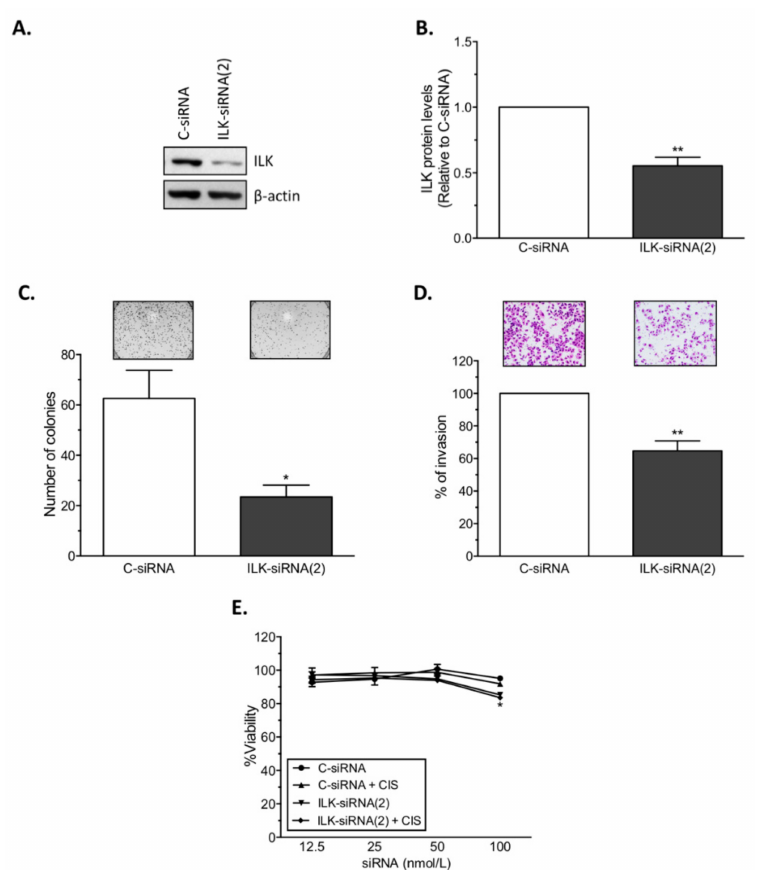
Figure 3. SiRNA-mediated ILK targeting in OVCAR3CIS cells. SiRNAs were transiently transfected into ovarian cancer cells. A reduction in ( A , B ) ILK protein levels, ( C ) colony formation, ( D ) invasion ability, and ( E ) cell viability was observed following ILK-siRNA transfection into OVCAR3CIS cells. Mean ± SEM is shown relative to C-siRNA (* p < 0.05 and ** p <